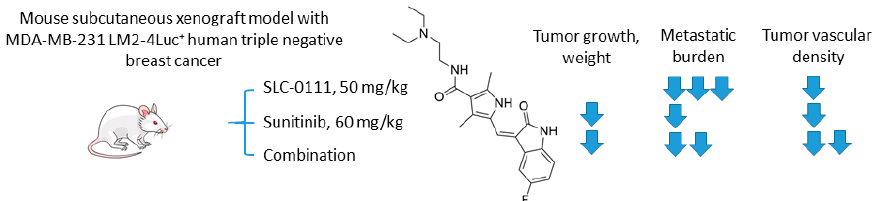
Figure 16. Graphical outline of the study on SLC-0111+sunitinib combination reported by Hedlund et al. [85].